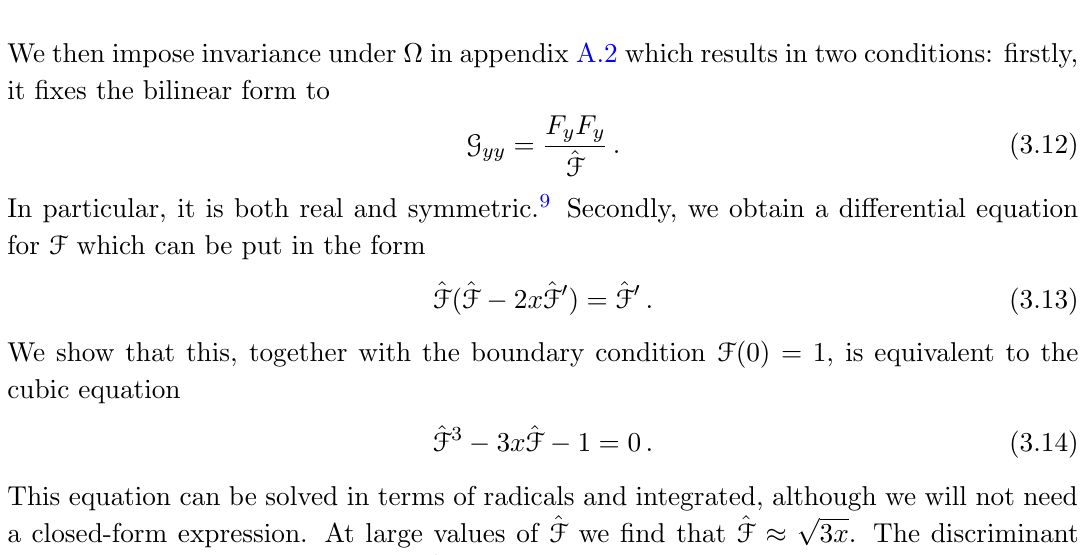
Figure 1 . The function ^ F ( x ) has two branches interpolating between the zero function and a parabola. On the left we plot ^ F and y 2 = 3 x . On the right we give a detail of ^ F and the vanishing locus x = 2 (cid:0) 2 = 3 (cid:25) 0 : 63 of the